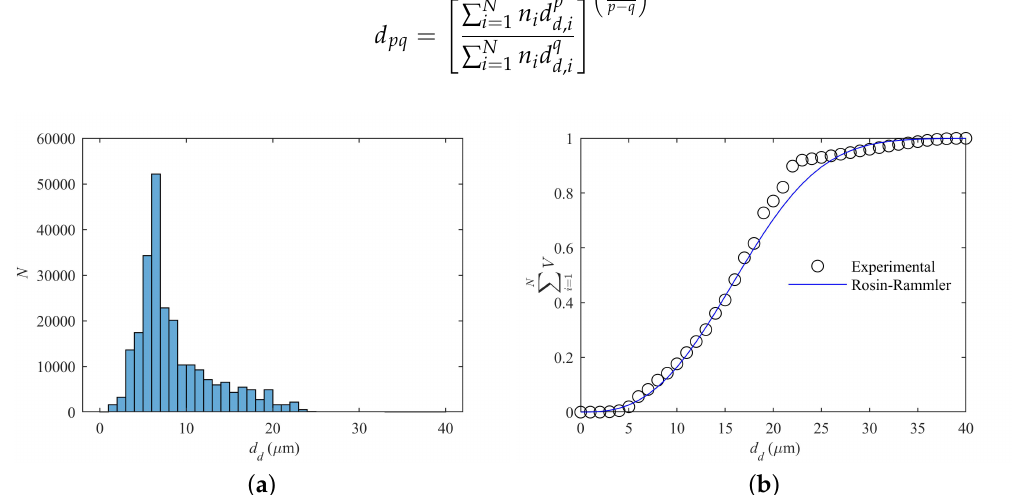
Figure 5. Experimental droplet distribution results: ( a ) histogram; and ( b ) cumulative mass distribution and Rosin–Rammler fit (Equation